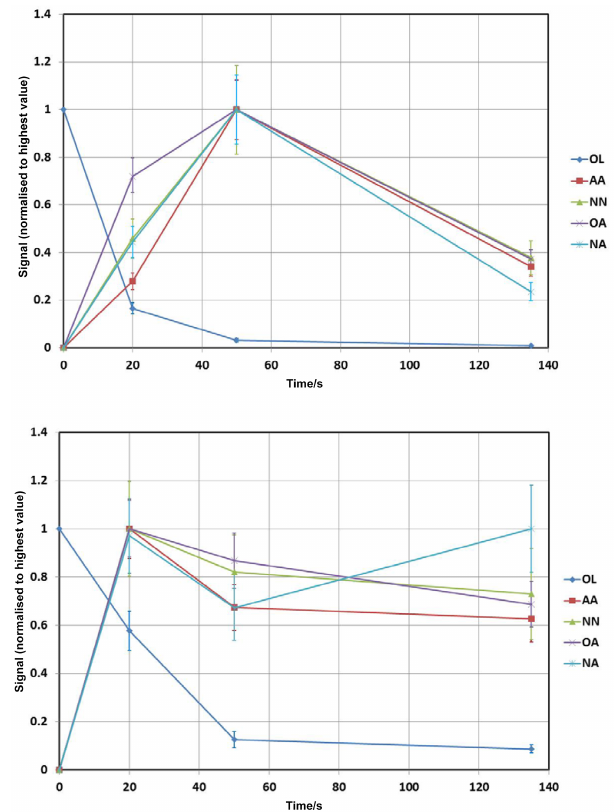
Figure 10. Time-dependent signals of oleic acid and the four ma- jor first generation ozonolysis products. The upper graph was ob- tained under dry conditions (RH = 0.5%) and the lower graph was obtained under wet conditions (RH = 65%). To aid ease of com- parison of the different time series, the signals for all investigated species have been normalised relative to the peak signal achieved by the species investigated. Error bars are 1 × the standard error of the